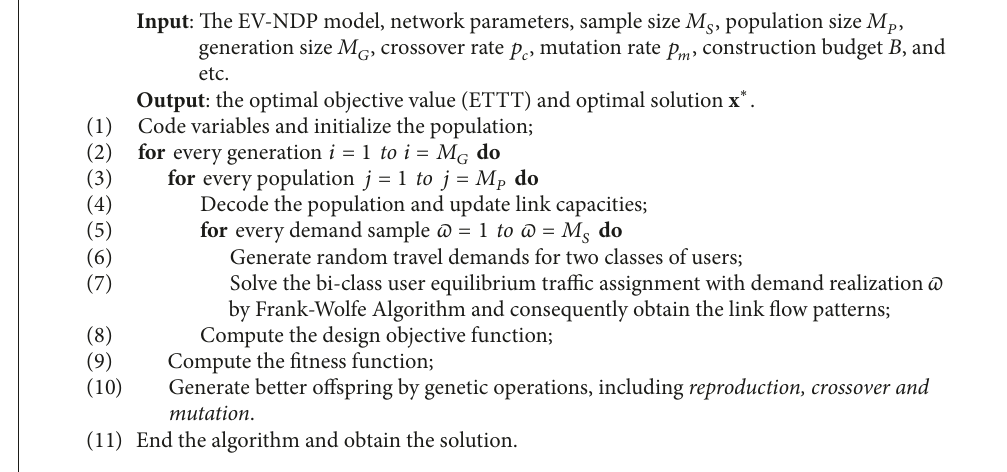
Algorithm 1: Simulation-based genetic algorithm.